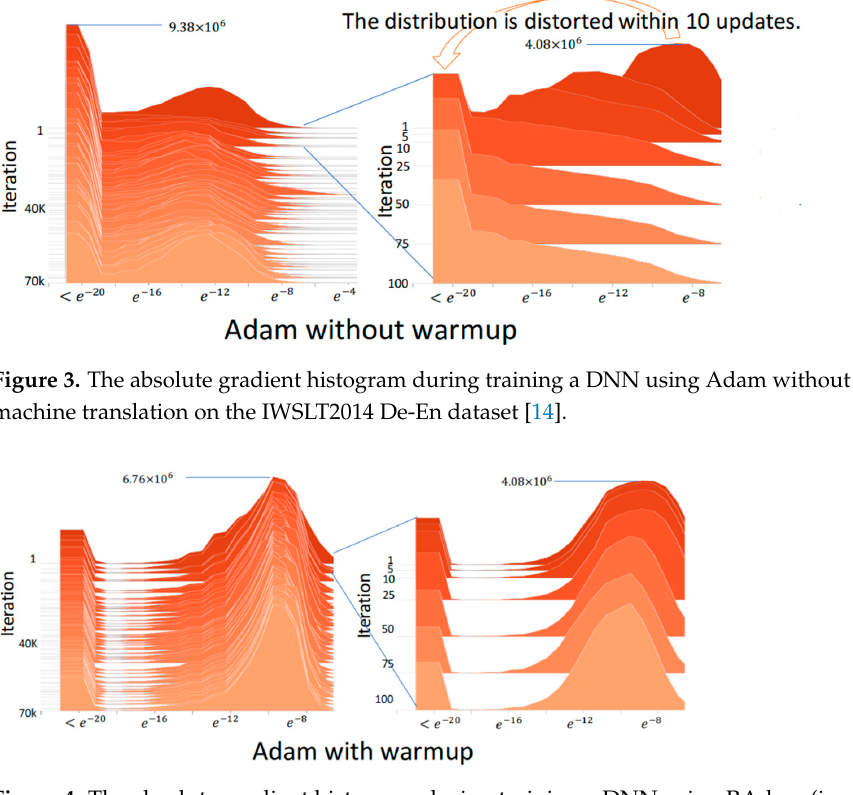
Figure 4. The absolute gradient histogram during training a DNN using RAdam (i.e., Adam with warmup) for machine translation on the IWSLT2014 De-En dataset